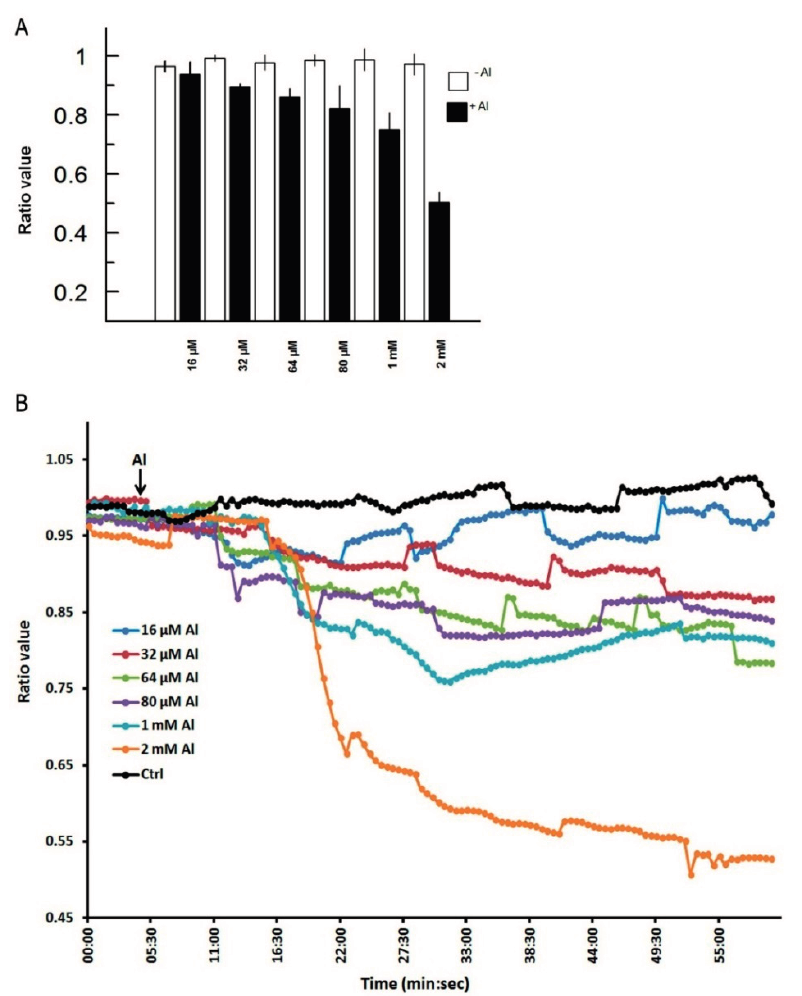
Figure 5. Intracellular levels of H 2 O 2 in Arabidopsis roots respond to Al treatment in a dose-dependent manner. ( A ) Roots were treated with different Al concentrations and the intracellular H 2 O 2 levels were evaluated as a ratio change of the Hyper probe. Note that higher concentrations of Al induce lower intracellular H 2 O 2 levels. n = 25 cells; ( B ) Graph depicting the representative response of Arabidopsis roots to various Al concentrations. Images were acquired at 30 s